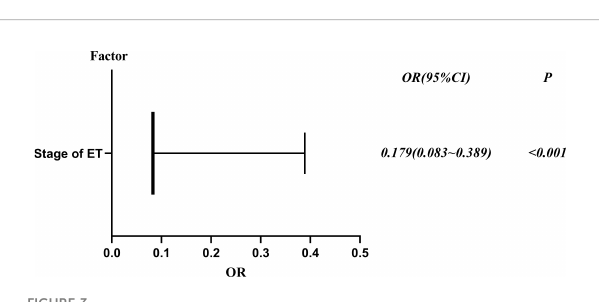
FIGURE 3 Risk factors of DCTA in the frozen ET cycle forest plot, OR (95% con fi dence interval) and P values.